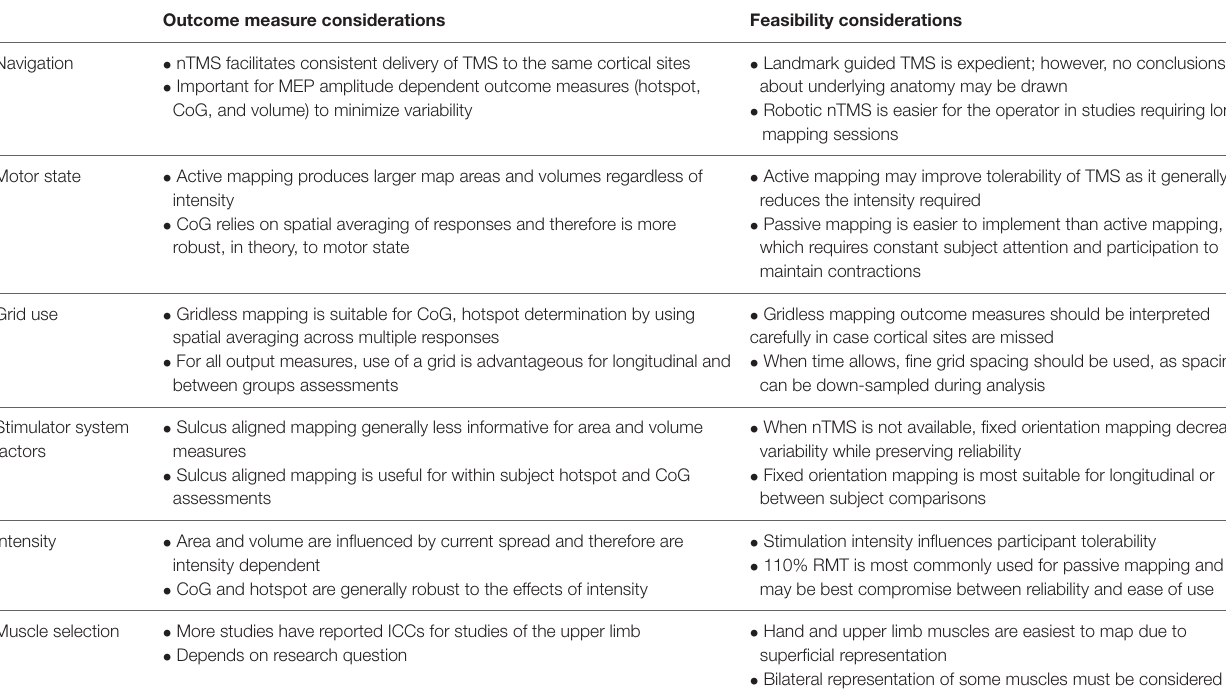
TABLE 1 | Effect of mapping parameters on outcome measures and